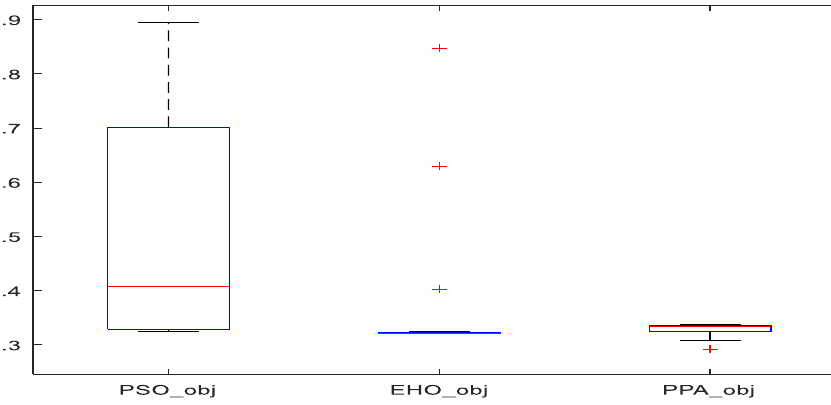
Figure 12. Eight-axis spider graph for index comparison among the algorithms.